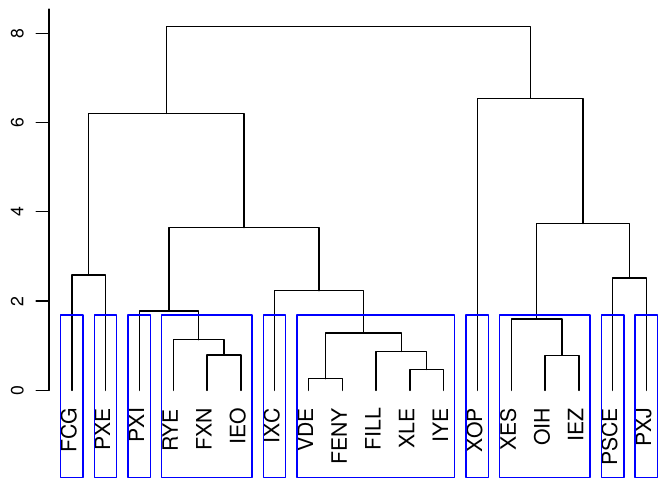
Figure A2. ETFs clustered by Ward’s Method with Euclidean distance.